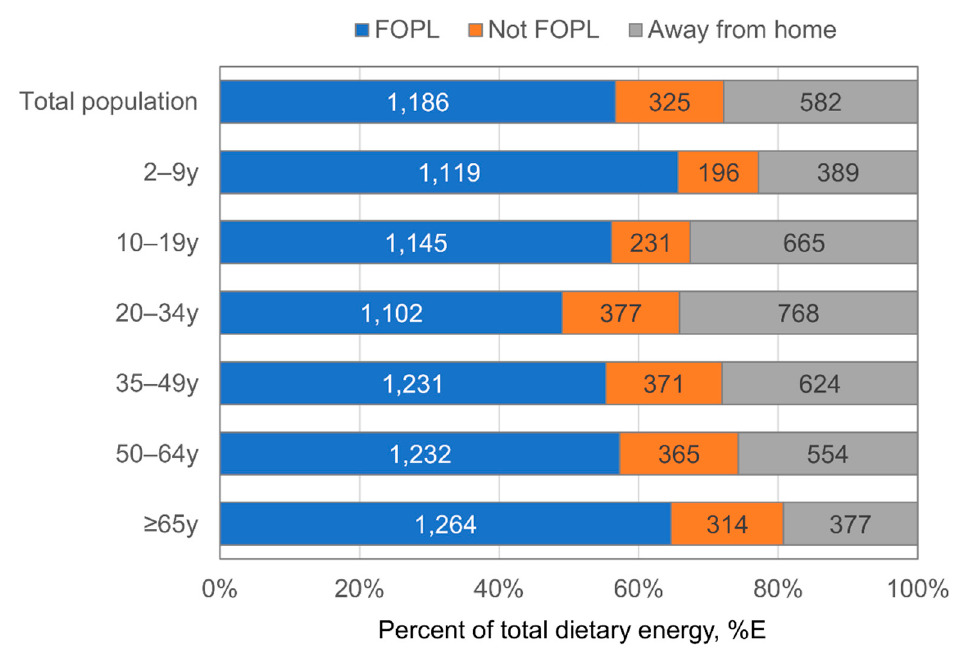
Figure 1. Daily energy (kcal/d) subject to FOPL (front of package labeling), not subject to FOPL but obtained from a store or other source where FOPL would be implemented and away from home among US population age ≥ 2 year, 2017–2018.